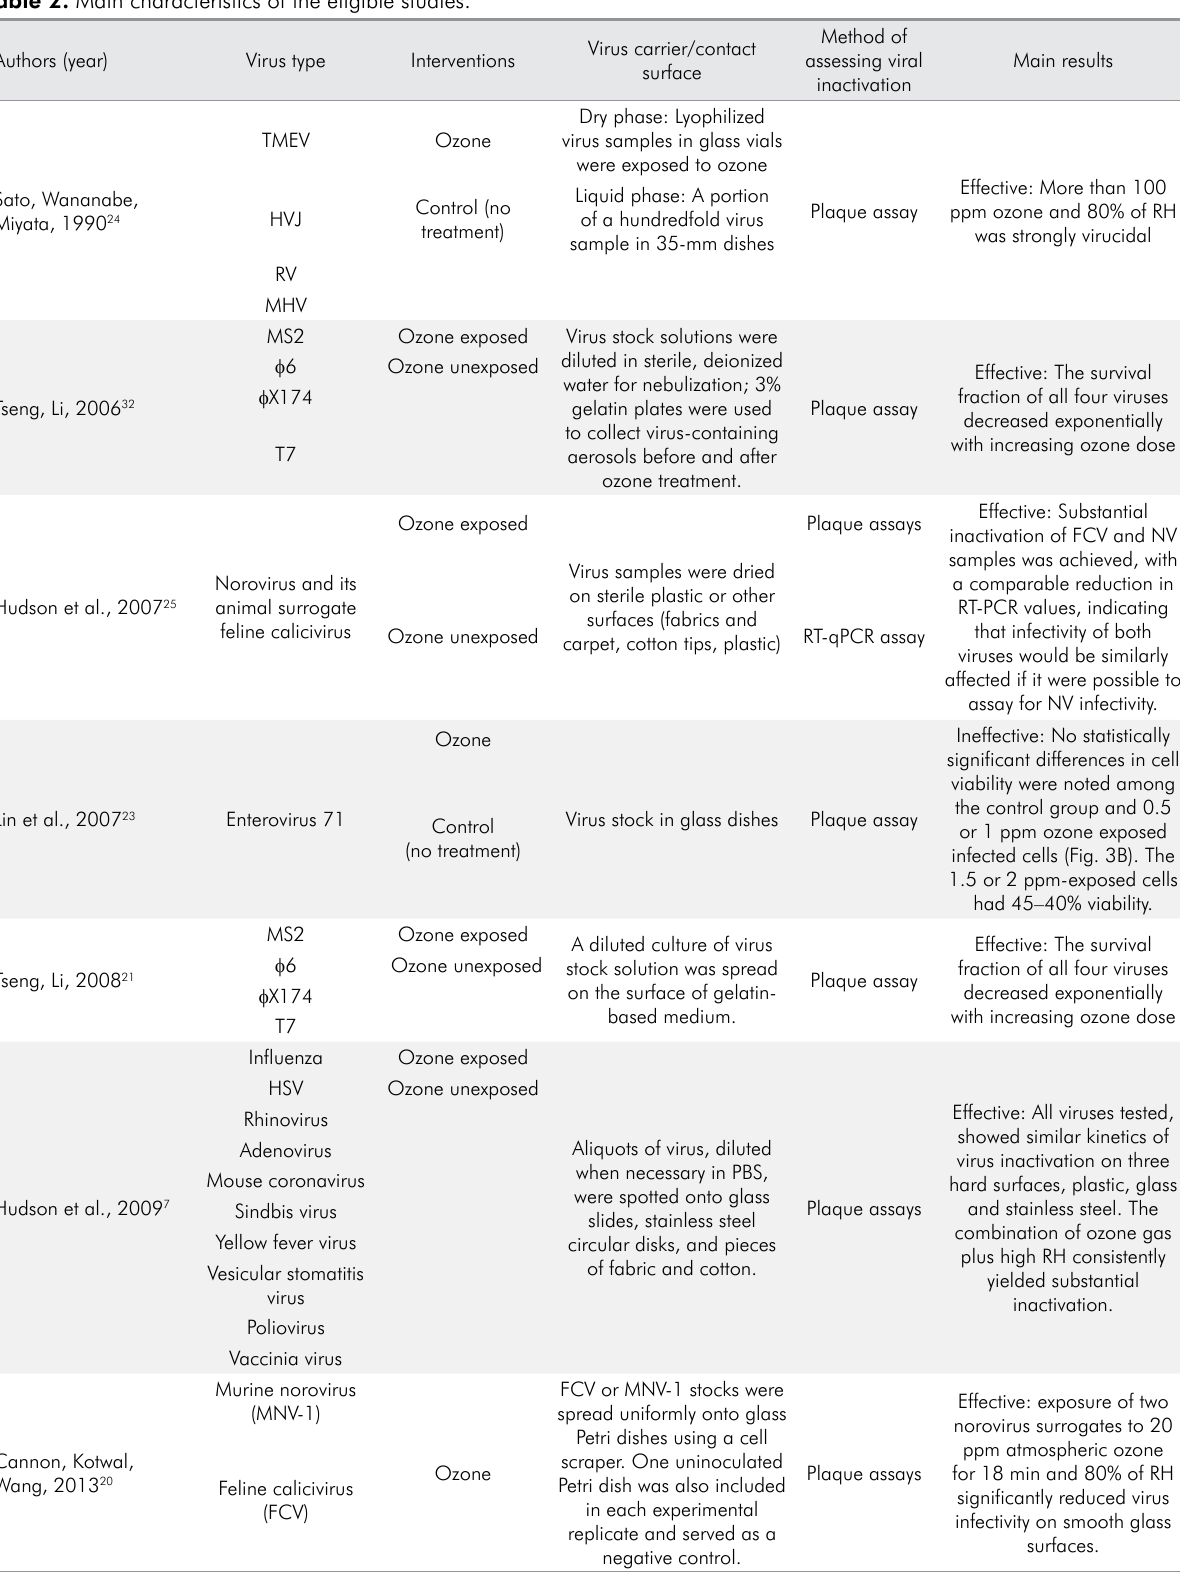
Table 2. Main characteristics of the eligible studies. Authors